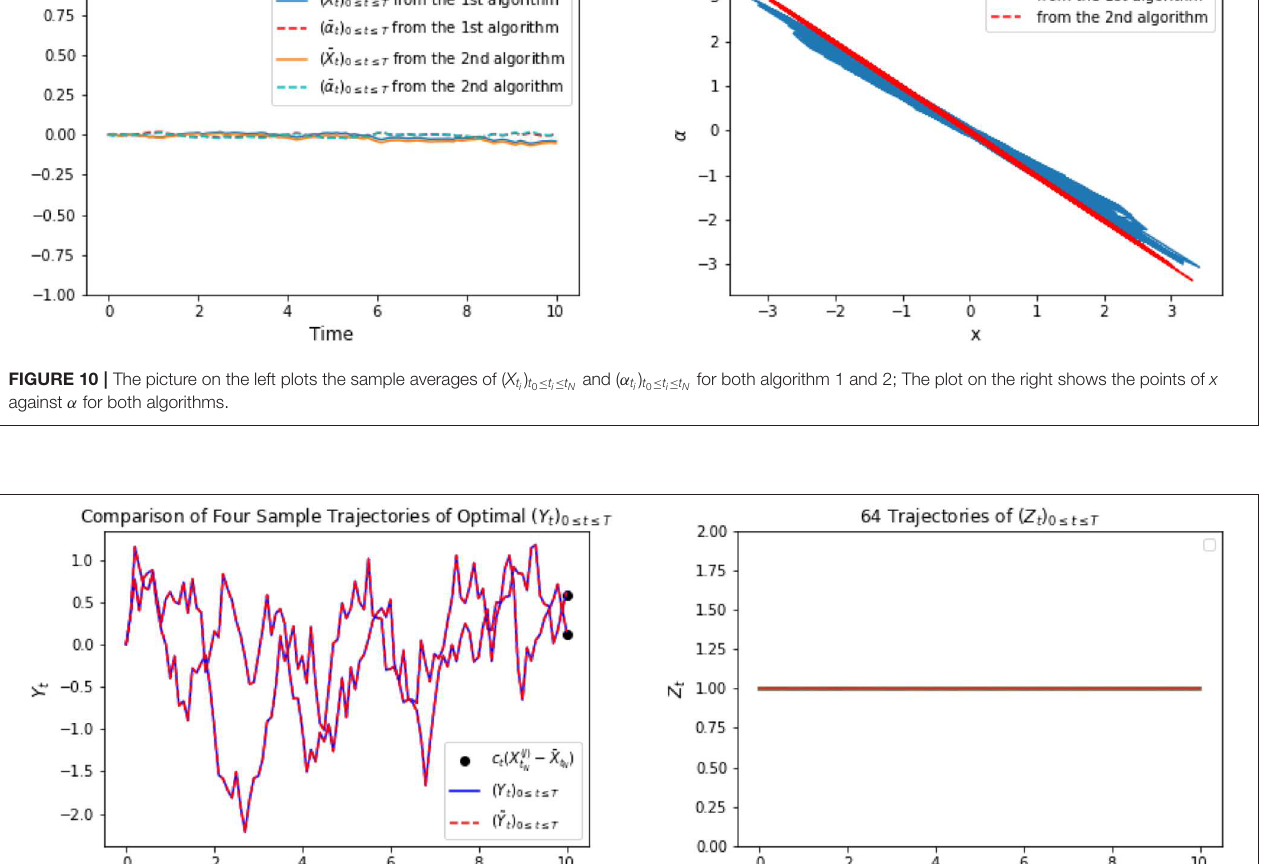
) t ,( ˜ Y t ) t ]. The picture on the right plots 64 trajectories of ( Z t i i 0 ≤ t i ≤ t N 0 ≤ t i ≤ t N